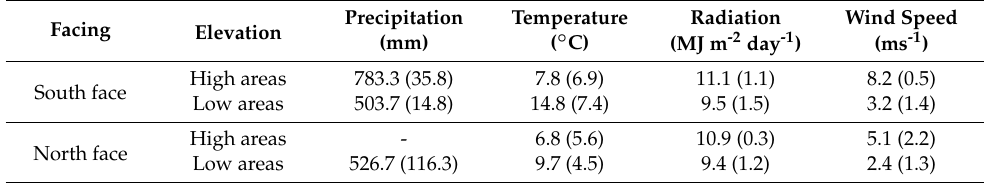
Table 1. Mean and standard deviation, in brackets, of the main meteorological variables in Sierra Nevada Mountains from 2009 to 2013, calculated over both south and north faces and for low areas (below 2000 m a.s.l.) and high areas (above 2000 m a.s.l.).